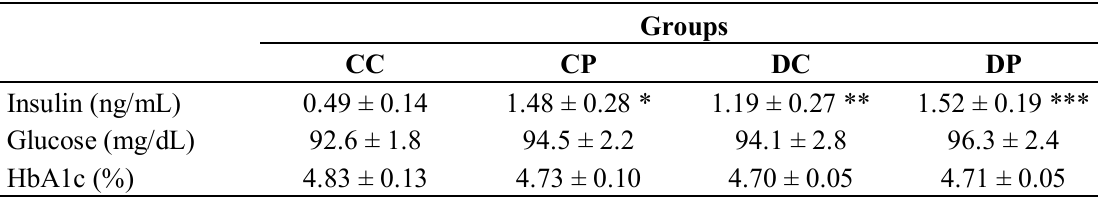
Table 3. Plasma insulin, glucose and HbA1c in rats after 12 weeks of treatment (means ±